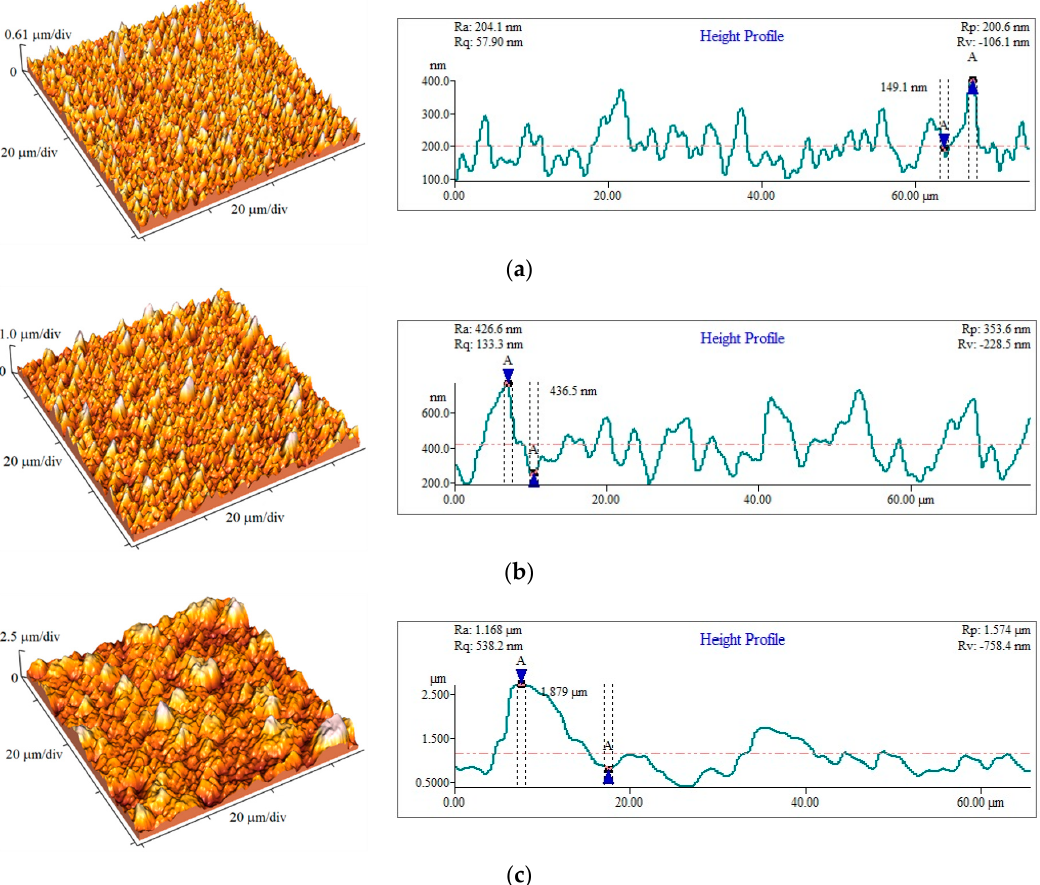
Figure 8. The AFM images and the corresponding line section analyses of Cu coatings obtained by the PC regimes: ( a ) δ = 10 µm, ( b ) δ = 20 µm and ( c ) δ = 60 µm. In all experiments: j A = 100 mA·cm − 2 , t c = 5 ms; t p = 5 ms, ν = 100 Hz. Scan area: 70 × 70 µm 2 .